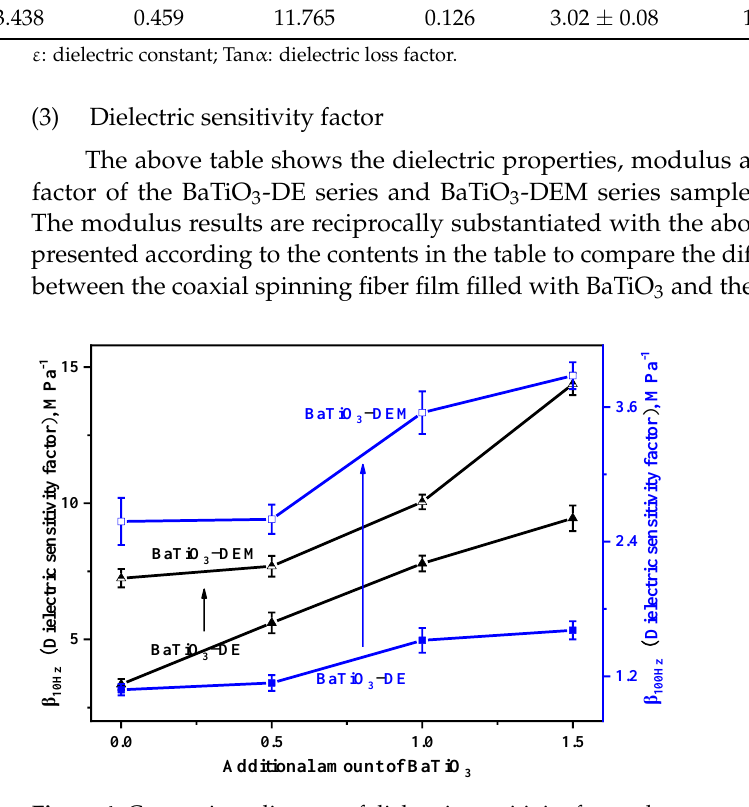
Figure 4. Comparison diagram of dielectric sensitivity factors between two kinds of samples.